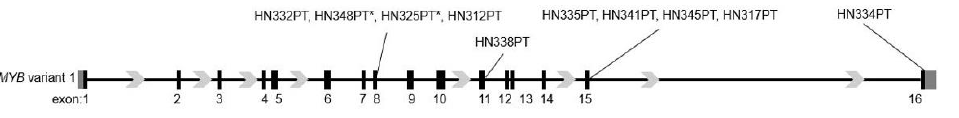
Figure 1. Schematic of MYB locus showing breakpoint locations. RNA-seq data from the indicated cases of ACC patient tumors was analyzed by combined NeoFuse and Arriba tool to identify MYB breakpoints. * Indicates cases where MYB breakpoint was also detected at exon 7.